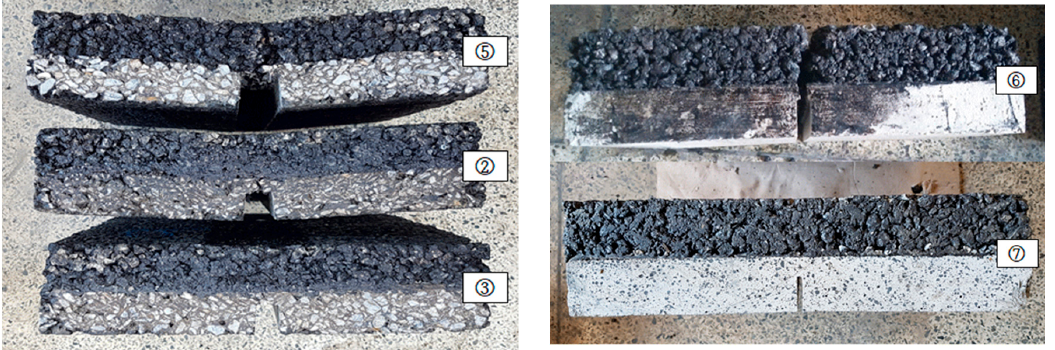
Figure 5. Side view of specimens after the completion of the MMLS3 experiment. Table 3. The number of loadings to failure for each specimen.